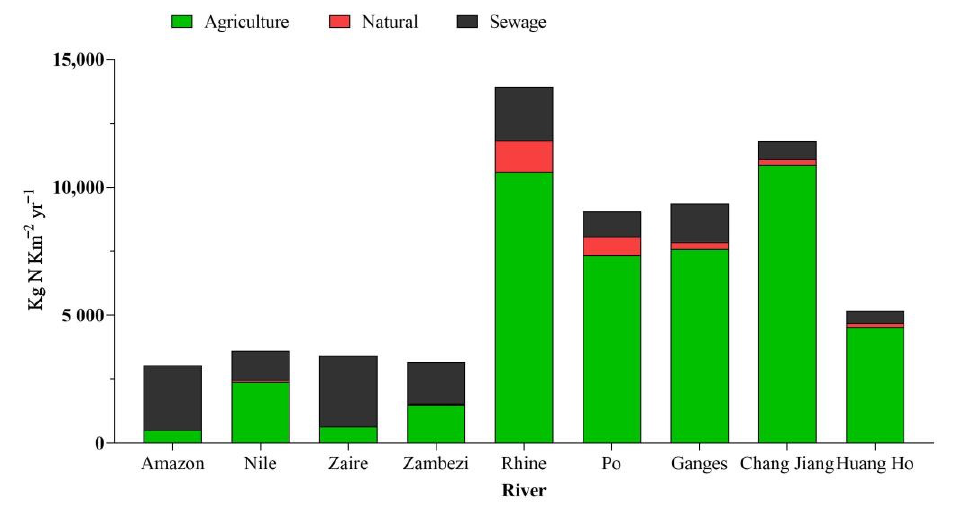
Figure 4. Nitrogen inputs in ten major river systems in the world [41 – 43]. Table 1. Common NUE indices and their values for N fertilizer for maize, wheat, and rice. Crops and Number of Continents